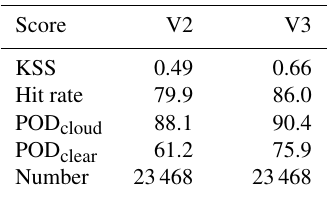
Table 3. Comparison of co-located AATSR cloud mask and CALIPSO 1km layer product for V2 (left) and V3 (right). The com- parison metrics shown are hit rate, the percentage of pixels identi- fied correctly as either cloudy or clear, the Probability Of Detection (POD) for cloudy and clear pixels separately, the Hanssen-Kuiper skill score (KSS; defined as KSS = TPR − FPR), and the total num- ber (cloudy and clear) of co-locations used in the analysis.